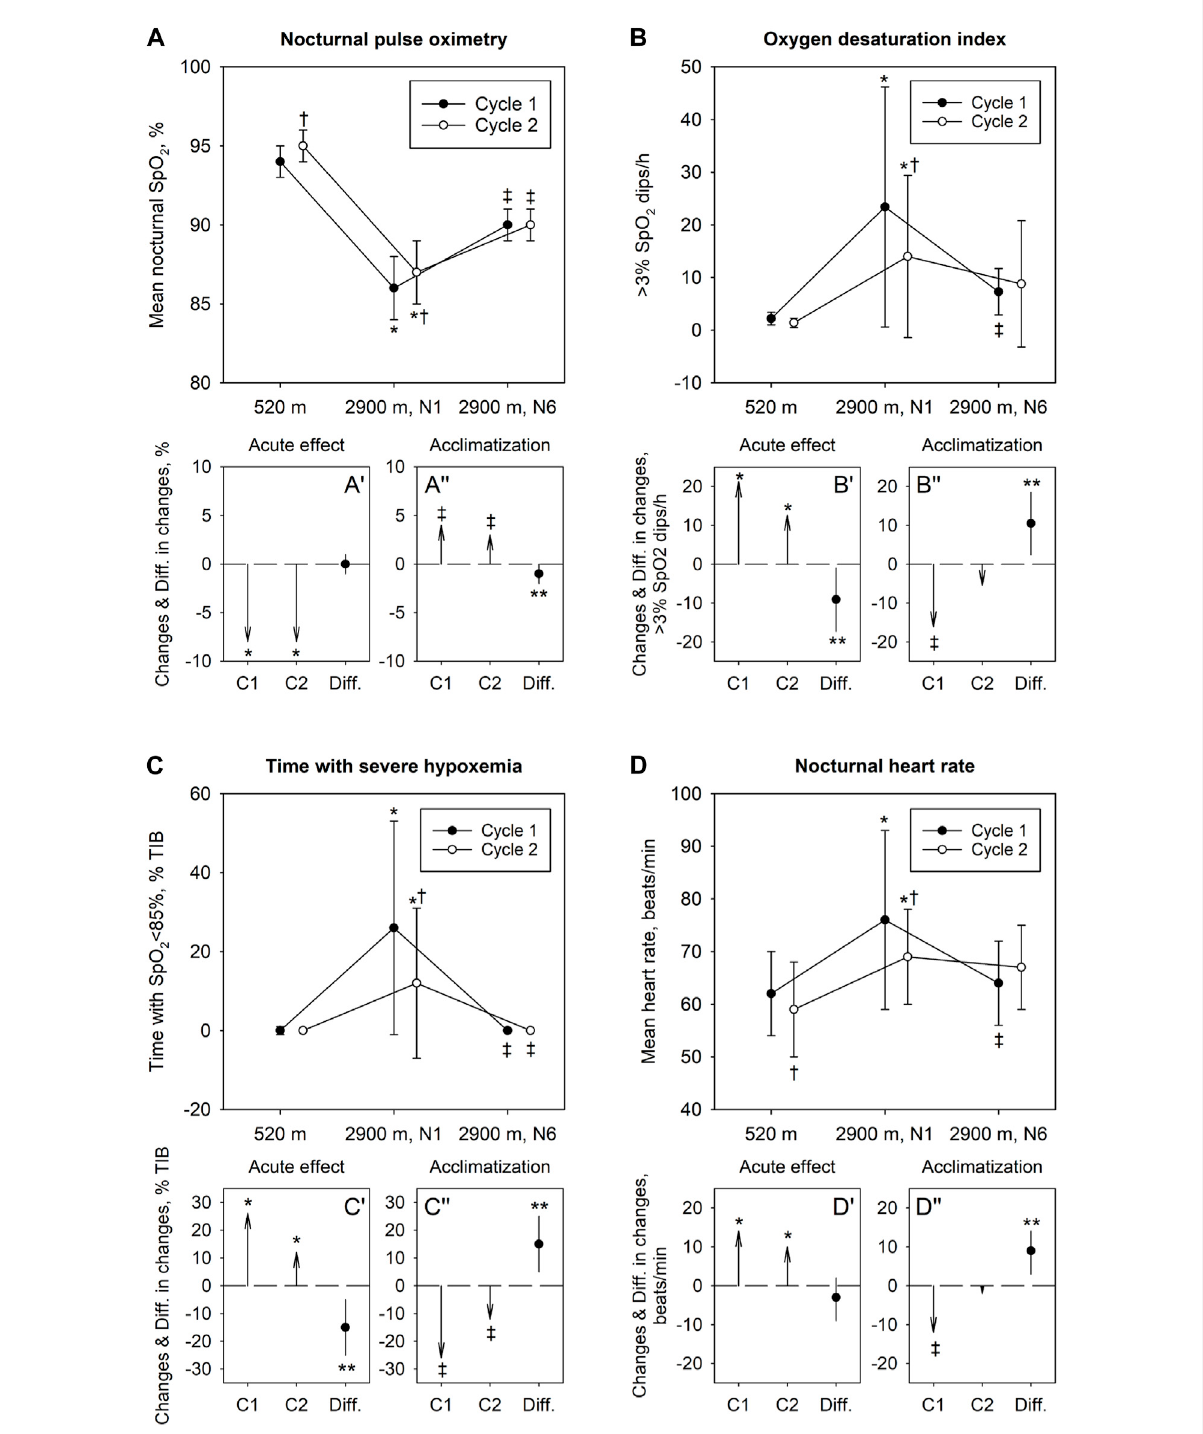
FIGURE 2 Effect ofacute high-altitude exposure, acclimatization andre-exposure onindices ofnocturnaloxygenation (A – C) andheart rate (D) . Inpanels (A – D) mean ± SD values at 520 m and at 2,900 m, nights 1 and 6, in the Cycle 1 and 2 are shown. Panels A ′ -D ′ illustrate changes in variables with acute ascent in Cycle 1 and 2 (vector arrows C1 and C2) along with their mean difference (Diff.) and 95% con fi dence interval. Panels A ″ -D ″ illustrate changes with acclimatization in Cycle 1 and 2 along with their mean difference and 95% con fi dence interval. * p < 0.05 vs 520 m in corresponding Cycle (acute altitude effect); ‡ p < 0.05 vs 1 st night at 2,900 m in corresponding Cycle (acclimatization effect). † p < 0.05 vs corresponding Baseline or value in Cycle 1, respectively (repeated exposure effect); ** p < 0.05 for differences between